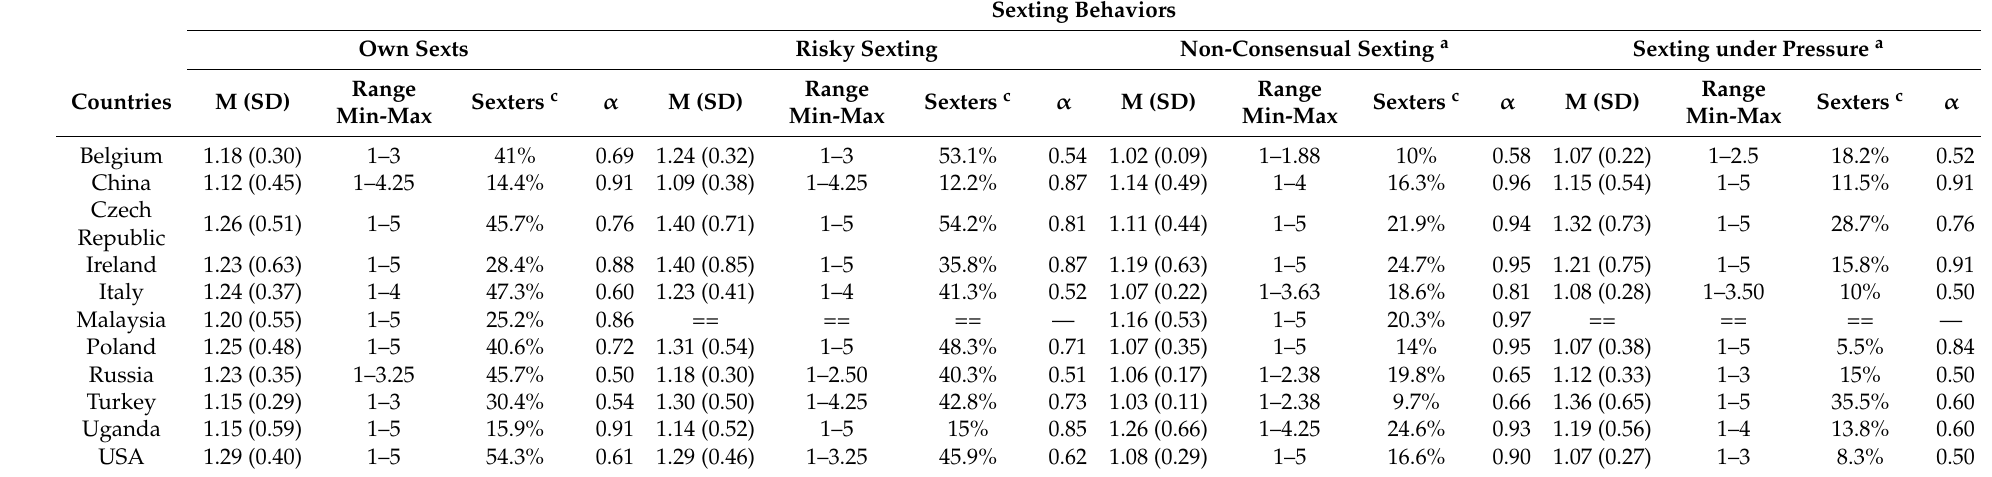
Table 2. Descriptive statistics of sexting by country.